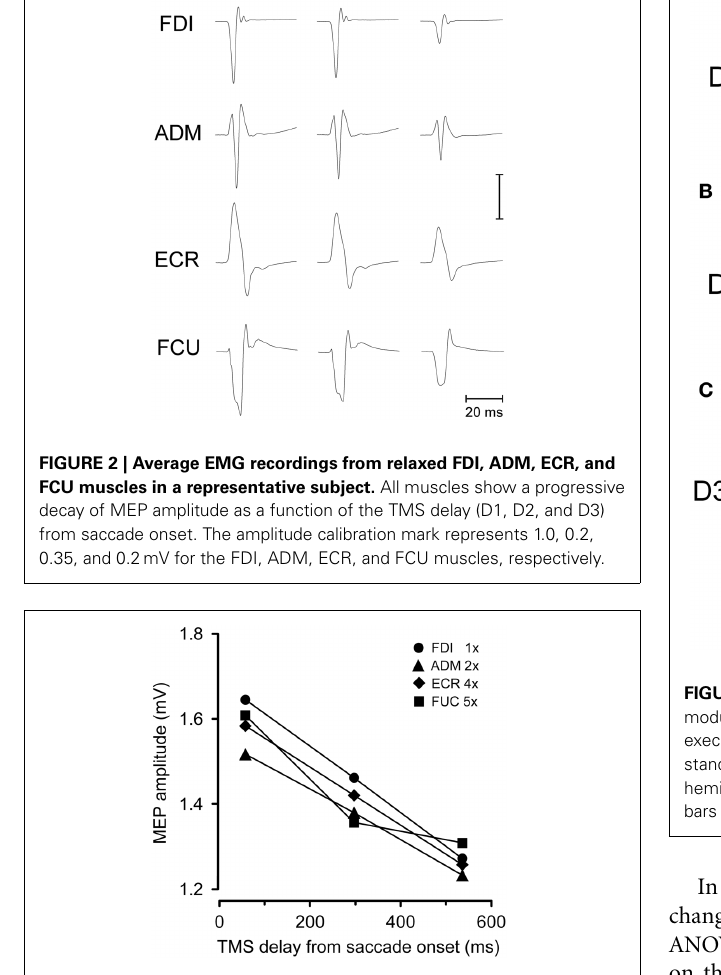
FIGURE 3 | Changes in mean MEP amplitudes as a function of TMS delay from saccade onset for each recorded muscle. Depicted MEP amplitudes represent the grand mean across subjects and target positions. MEP amplitudes for different muscles have been scaled according to the values shown in the legend.